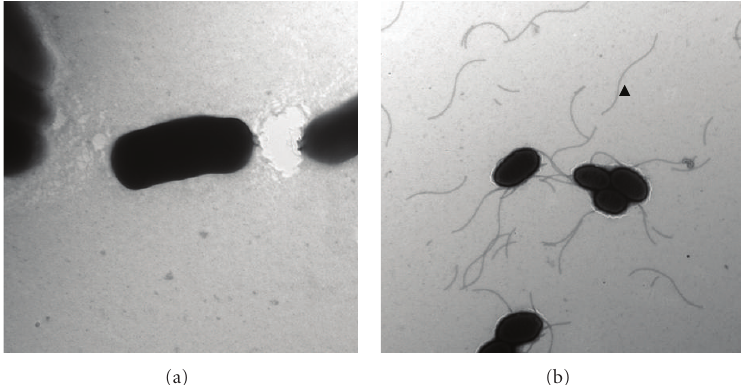
Figure 2: Observation of Salmonella enterica subsp. enterica serovar Typhimurium LB5010 and the stbC mutant strain grown on solid agar. (a) Salmonella enterica subsp. enterica serovar Typhimurium LB5010 grown on LB agar at 37 ◦ C for 16 h did not produce fimbrial appendages. (b) The Salmonella enterica subsp. enterica serovar Typhimurium stbC mutant grown on LB agar at 37 ◦ C for 16h exhibited flagella structures (arrowhead) but no fimbrial appendages were observed (3,000x). Bacterial cells were negatively stained with 2% of phosphotungstic acid